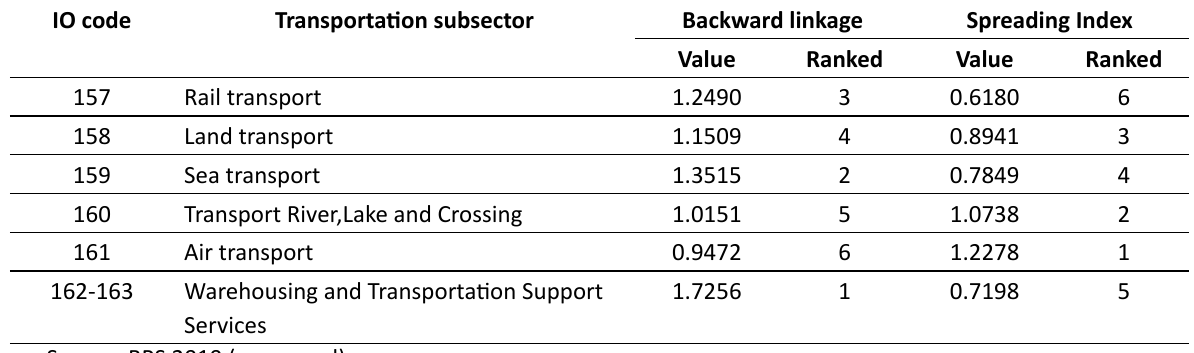
Table 2: Backward Linkage Index Transportation Subsector Indonesia Year